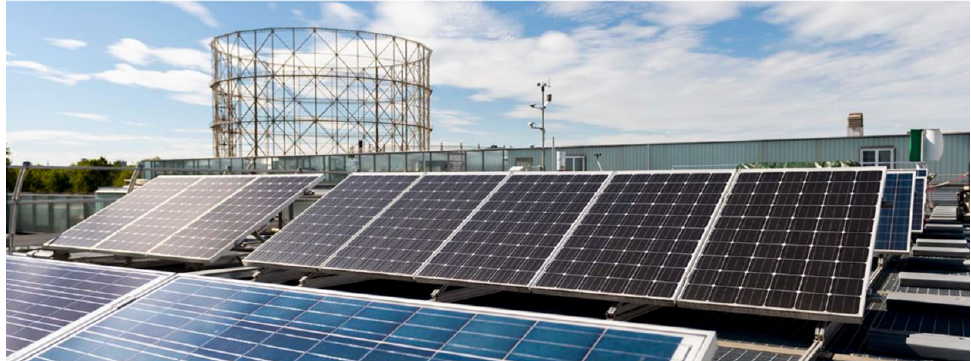
Figure 1. SolarTech LAB PV facility at Politecnico di Milano,